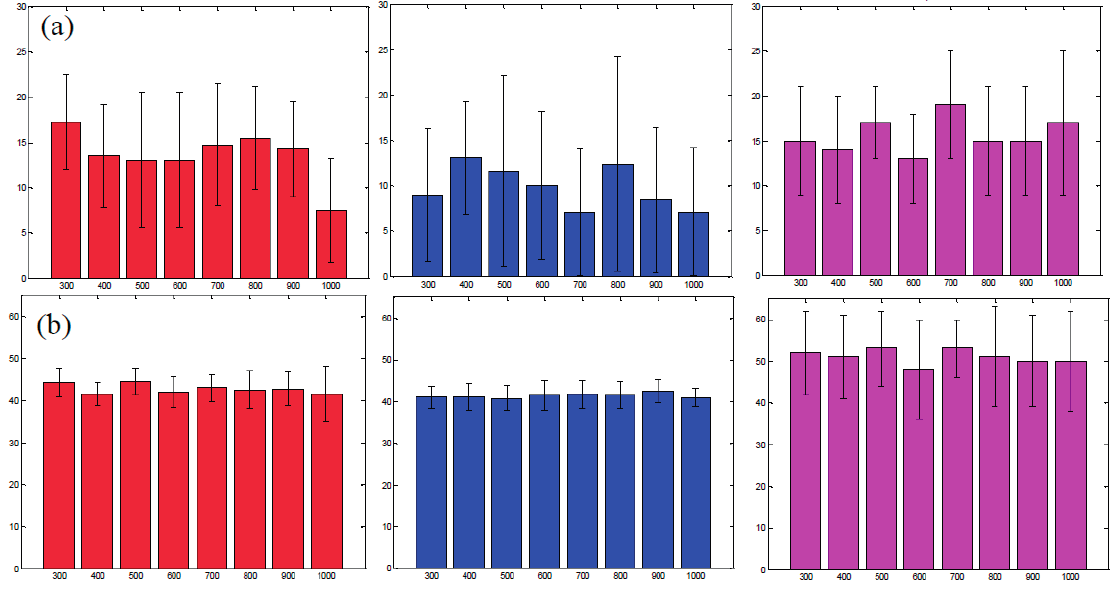
Figure 7. Validation of a change in gate width on ( a ) A 1 = 12% and ( b ) A 1 = 40% for in vitro ( left ), in silico ( middle ), and in vivo ( right )